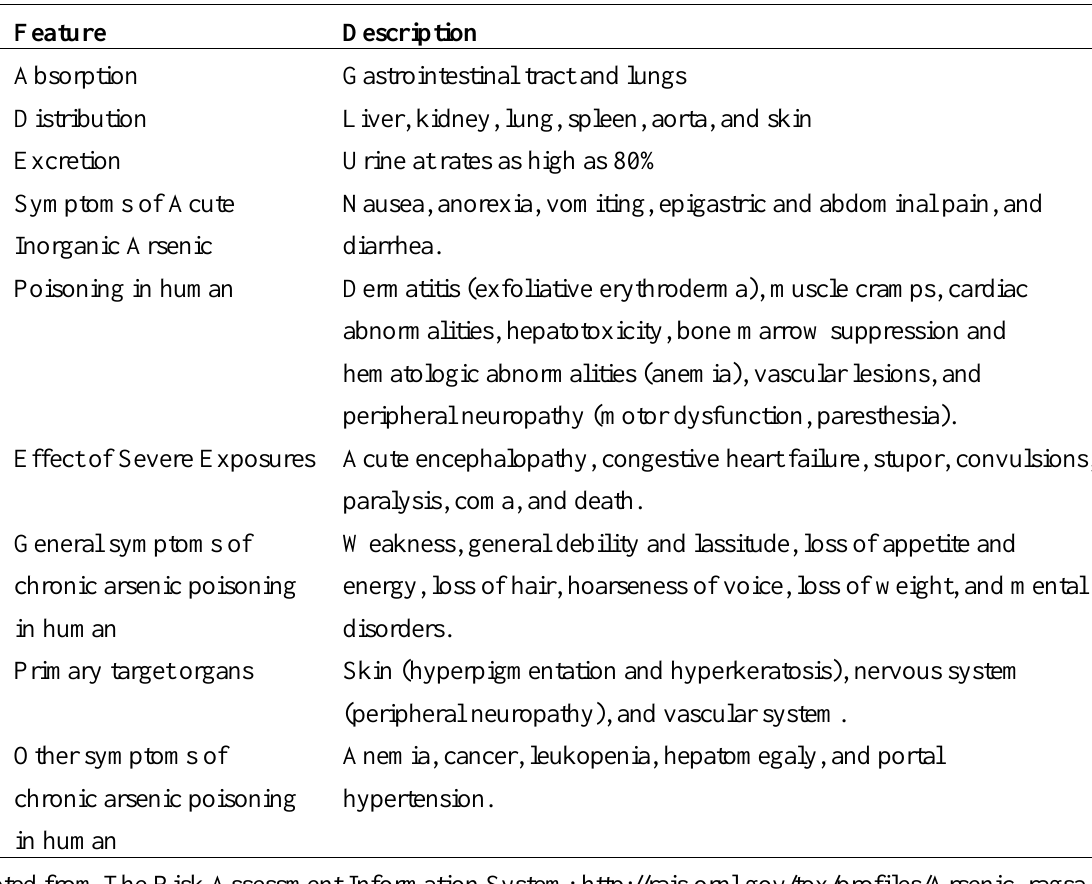
Table 1. Selected toxicity features of water soluble inorganic arsenic compounds a